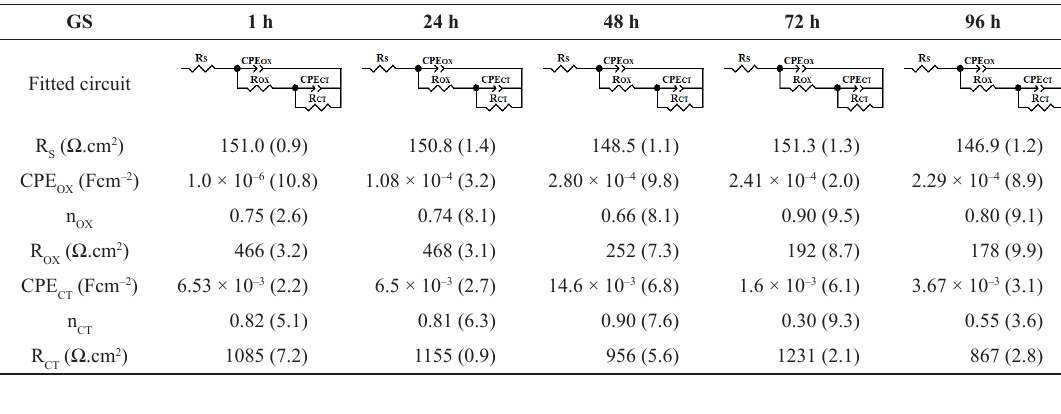
Table 9. Electrical elements fitted values for GS up to 96 hours of immersion in a 0.05 mol.L -1 NaCl solution.